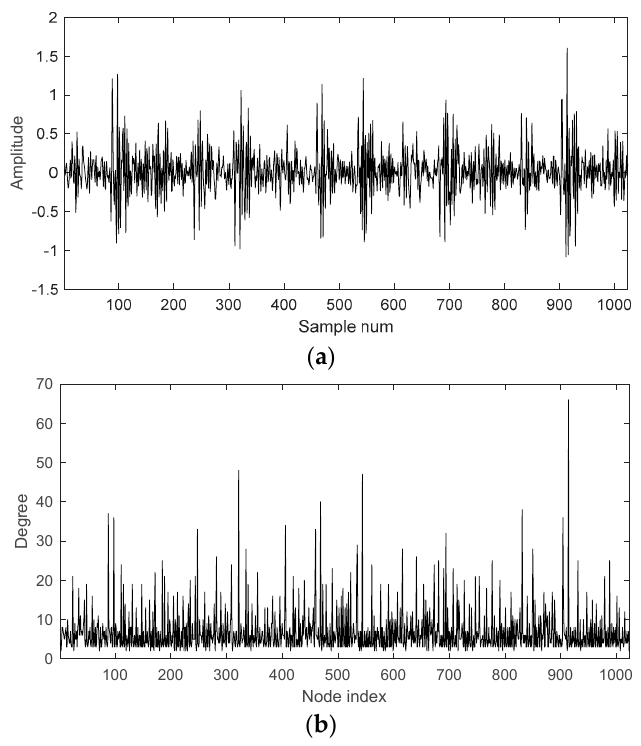
Figure 4. ( a ) A sample of faulty data and ( b ) degree distribution of its VG.